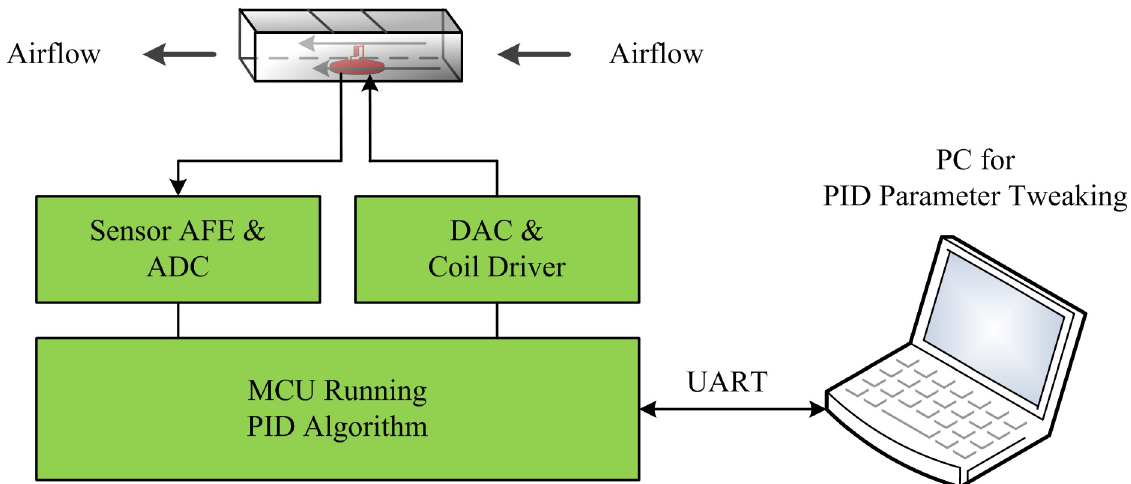
Fig 12. Schematic diagram of PID parameter tuning